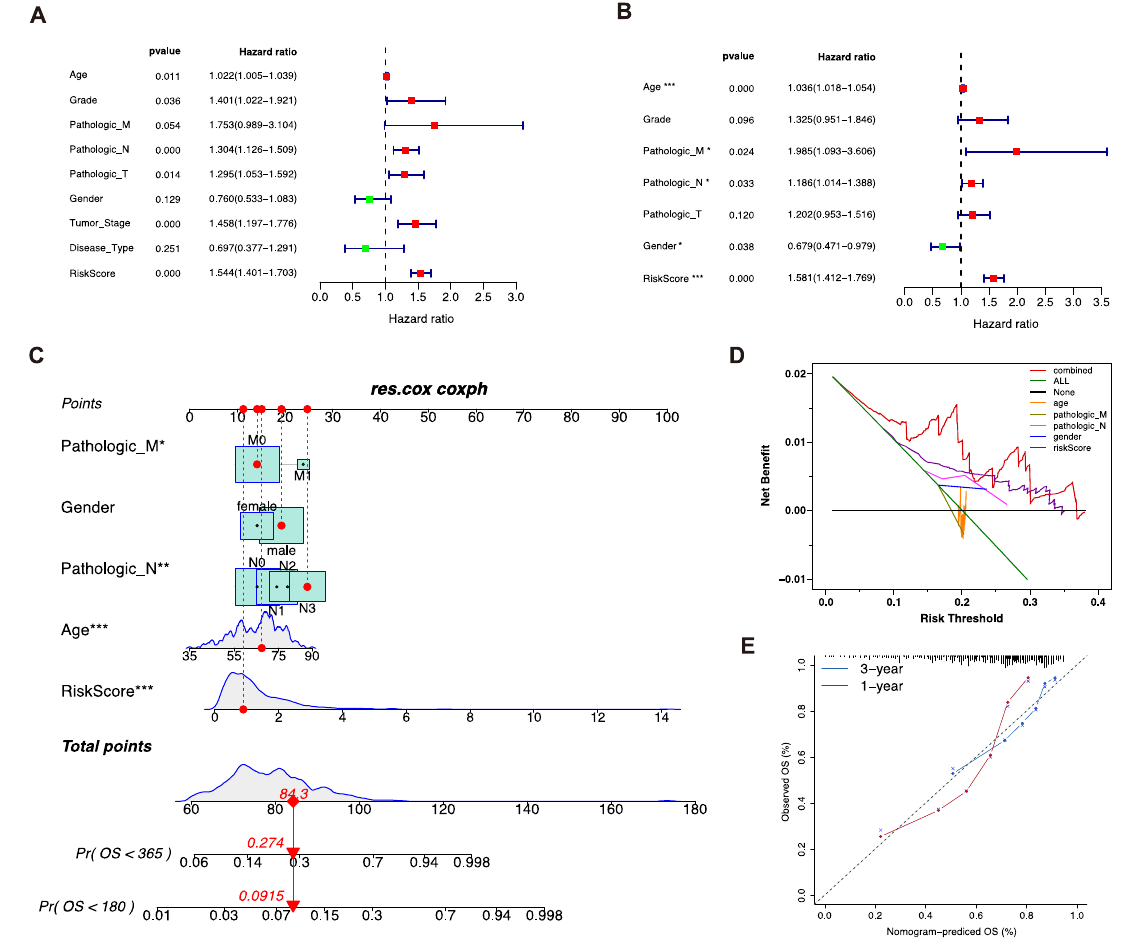
Figure 3. Establishment of nomogram. ( A , B ). Univariate and multivariate Cox regression analysis of clinical factors and risk score for overall survival. ( C ). Independent prognostic factors in multivariate Cox regression analysis for construction of Nomogram. ( D ). Decision curve analysis for comparison of multiple models to predict the overall survival of patients. ( E ). Calibration curves of nomogram for 1 and 3 years (*, ** and *** = significant at 0.05, 0.01 and 0.001 levels, respectively).